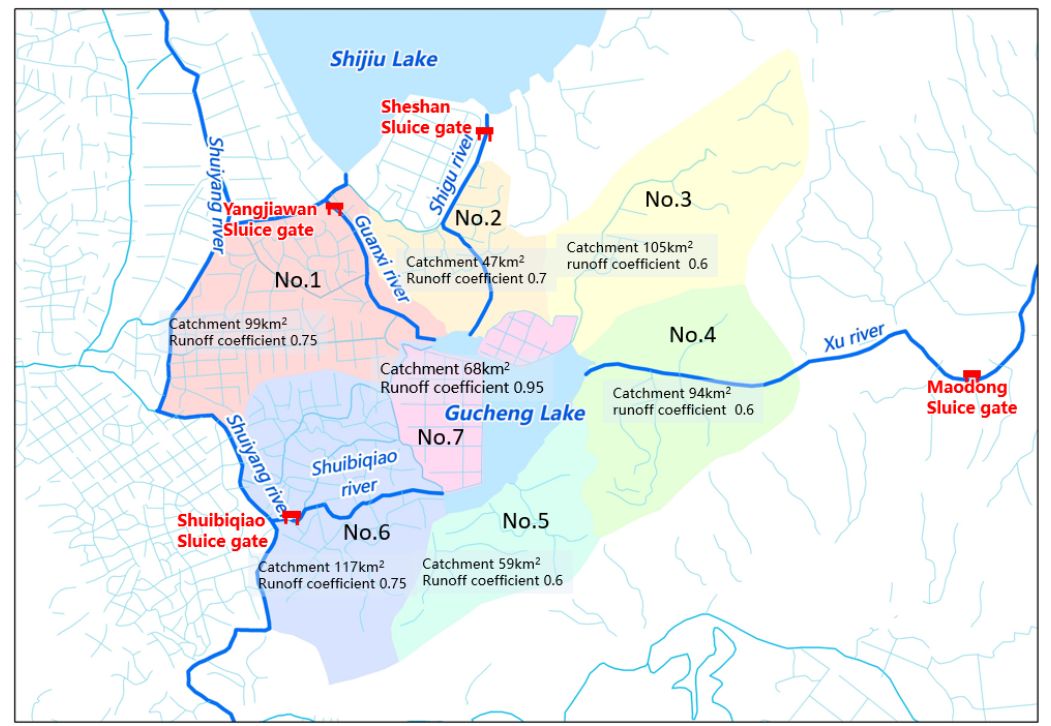
Combining the DEM data and the conditions of the river and lake water systems, the total catchment area of Gucheng Lake water system is calculated to be 589 km 2 . According to the confluence situation of the rivers, the catchment area of Gucheng Lake is divided into seven catchment areas: Shuibiqiao River, Guanxi River, Shigu River, Qiqiao River, the Southern Mountains and Gucheng Lake (Figure 1). According to the current situation of land use in the Gucheng Lake catchment area, the underlying surface of each catchment area and the comprehensive runoff coefficient before and after urban development are shown in Table 1.